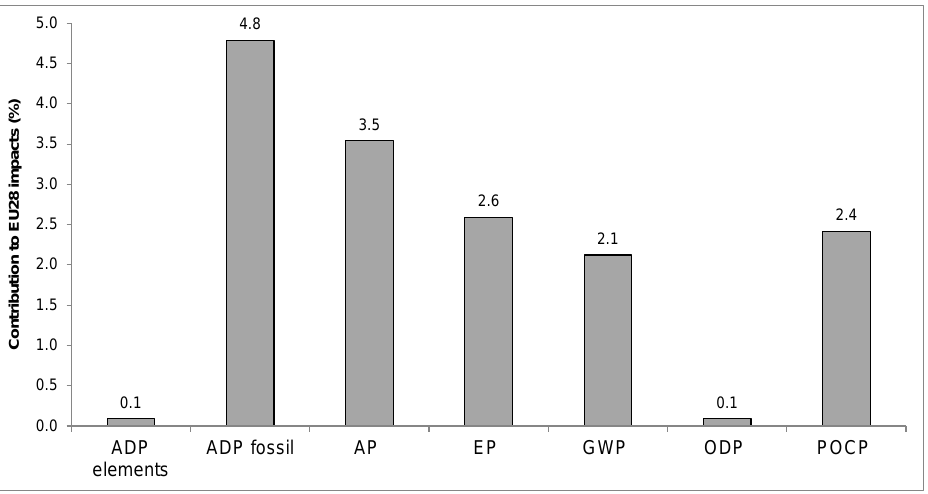
Figure 8. Annual impacts from electricity generation in Turkey in the base year (2010) normalised to the annual EU28 impacts. [EU28: the European Union with 28 countries. All data for the EU28 impacts are for the year 2000, the latest available data in the CML 2001 method. For impacts nomenclature, see Figure 3.].